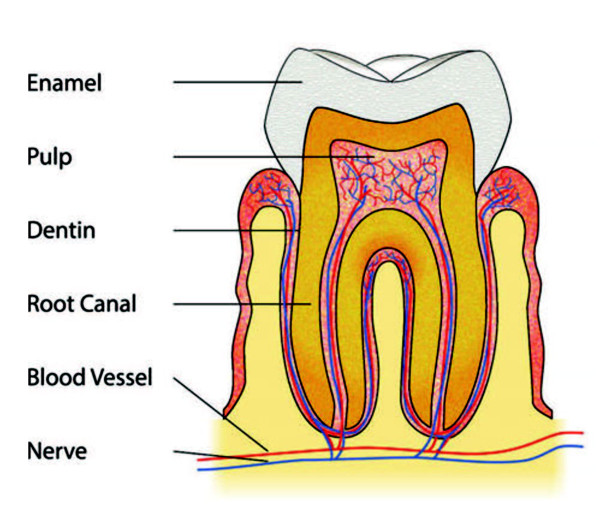
The different components of a tooth[153].